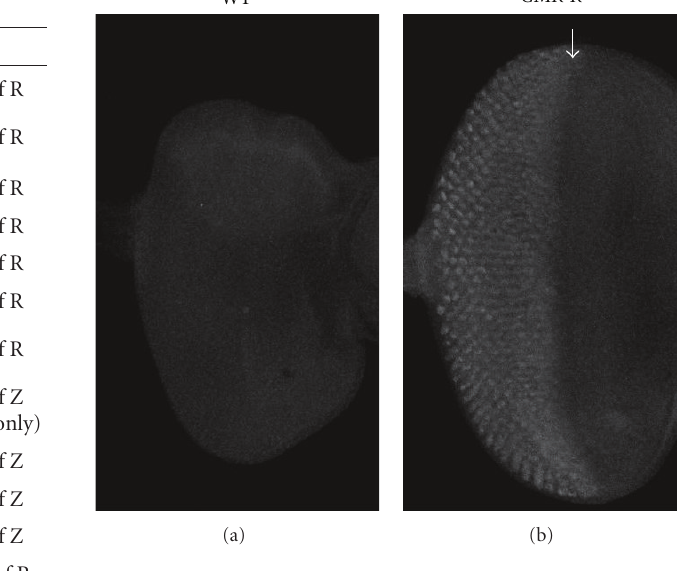
Figure 1: BRLF1 protein expression in the GMR-R /+ eye imaginal disc. Wild-type (a) and GMR-R/+ (b) imaginal eye discs were stained with an anti-BRLF1 antibody. Confocal microscopy was used to image the discs. The arrow refers to the morphogenetic fur-